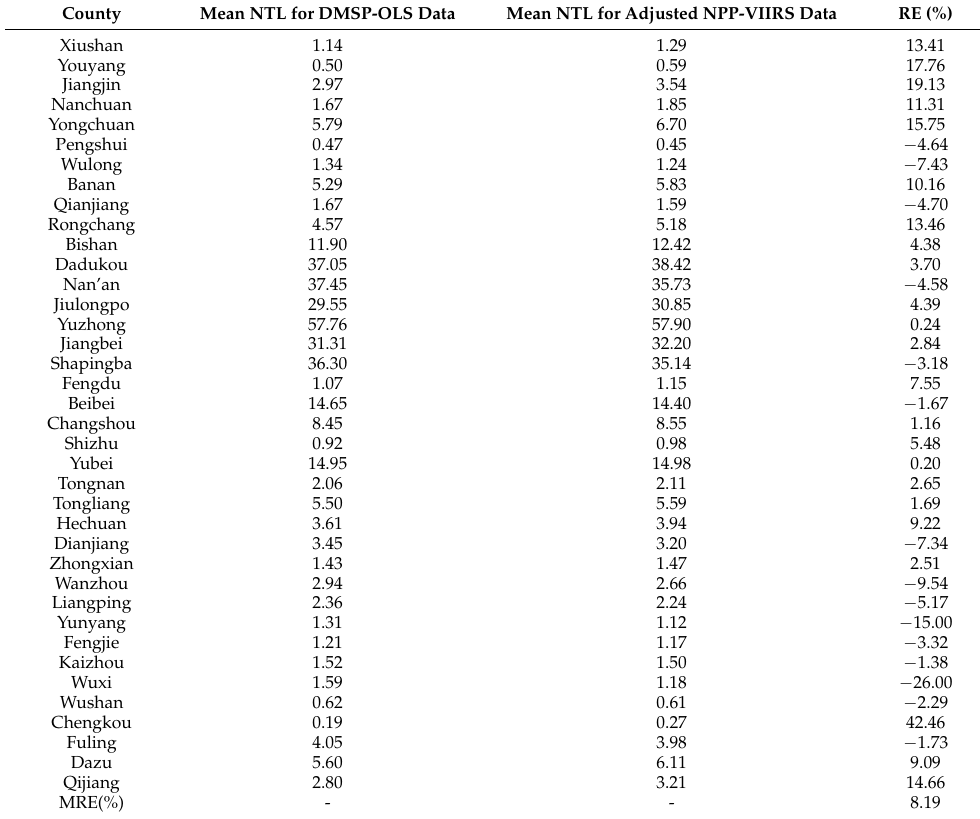
Table 2. Accuracy assessment of the NTL integrated data by